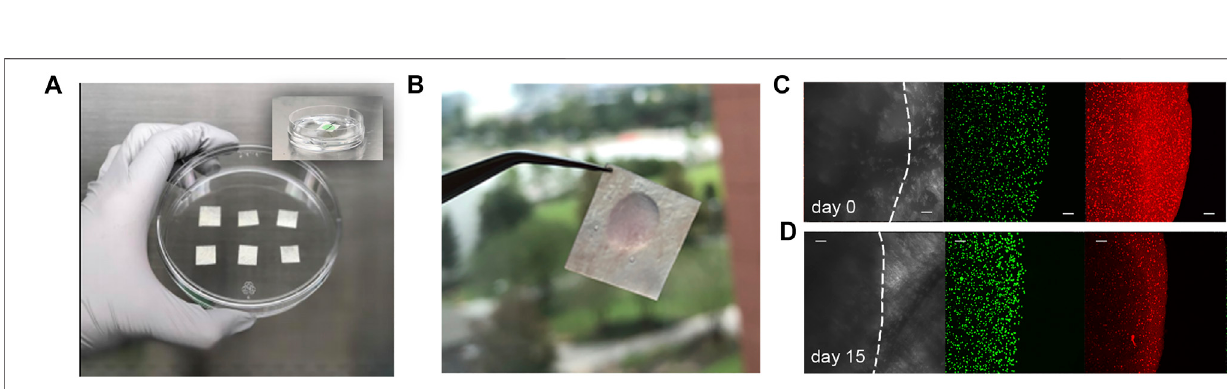
Frontiers in Molecular Biosciences |